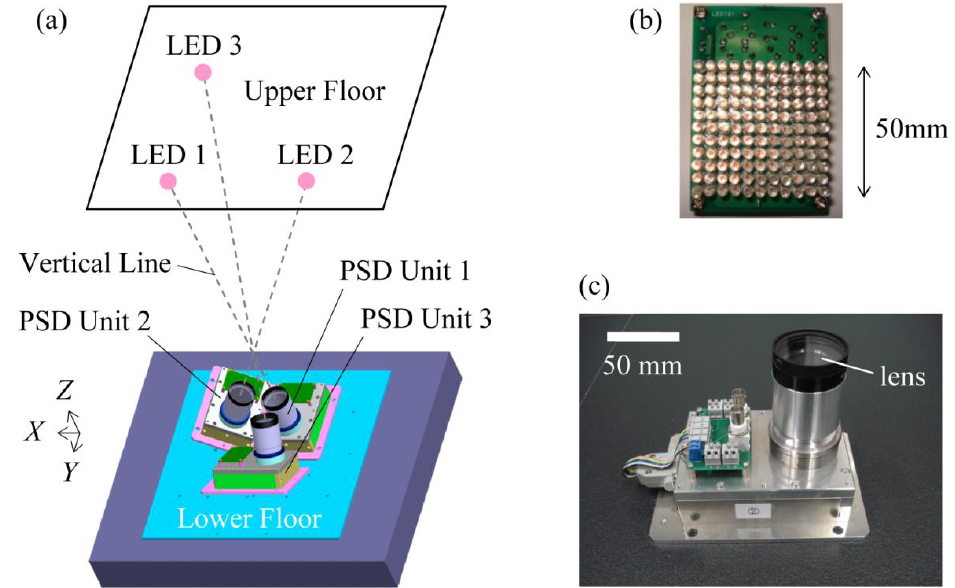
Figure 1. Schematic diagram of the relative-story displacement sensor. (a) Arrangement of three LEDs and three PSD units (Birds eye view); (b) Photographs of the LED array; and (c) the PSD unit.